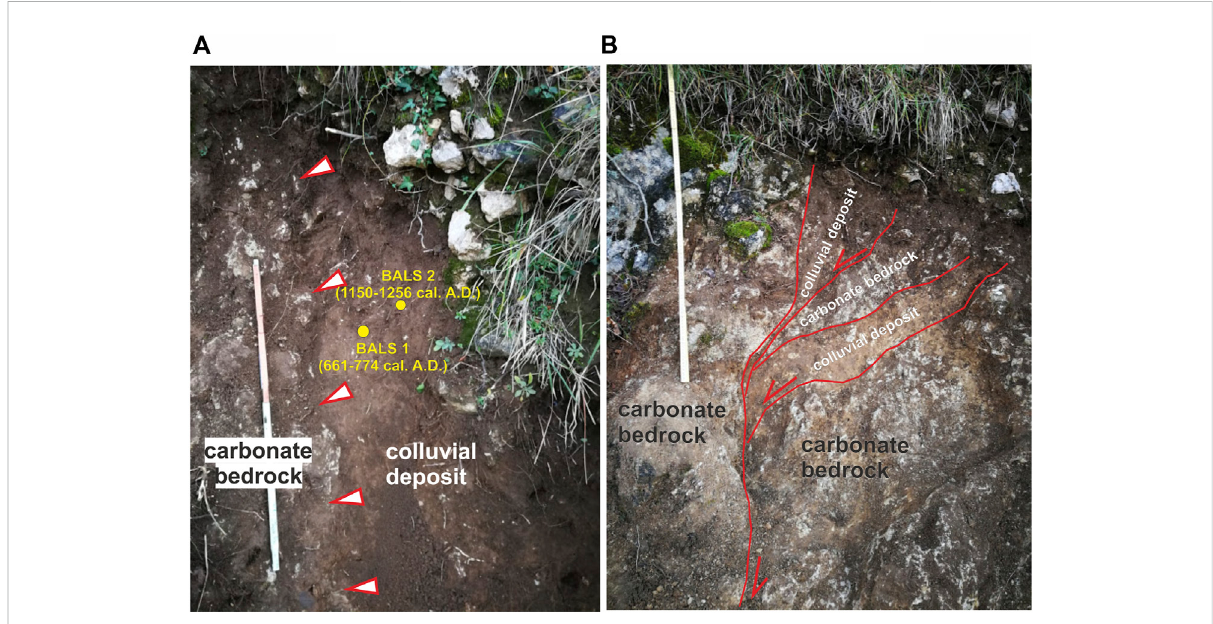
FIGURE 9 (A) Details of the excavation wall made at the “ Le Chieie ” site. The close-up view shows the contact between the limestone and the colluvial deposit, marked by white – red arrows; the yellow dots indicate the location of the dated charcoals reported in the main text. (B) Details of the shear zone whose movement involves the carbonate bedrock and the colluvial